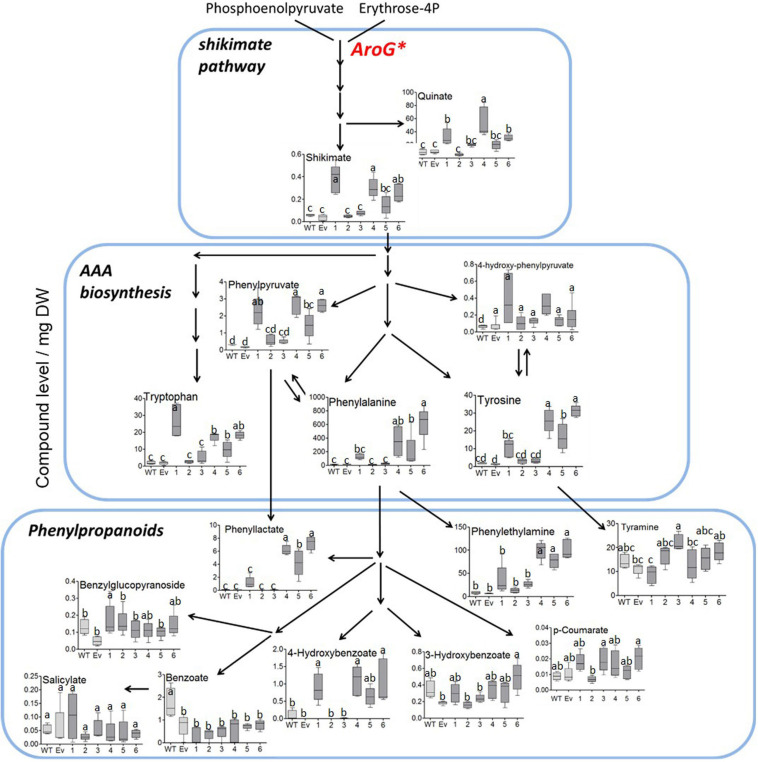
Levels of AAAs and their associated metabolites as detected by GC-MS in the leaves of WT (n = 4), EV (n = 5) and transgenic tobacco AroG lines #1–6 (n = 5). Results are presented on a pathway scheme with the graph representing compound level as the peak area normalized to the internal standard (norleucine) and calculated for 1 mg of dry weight (DW).